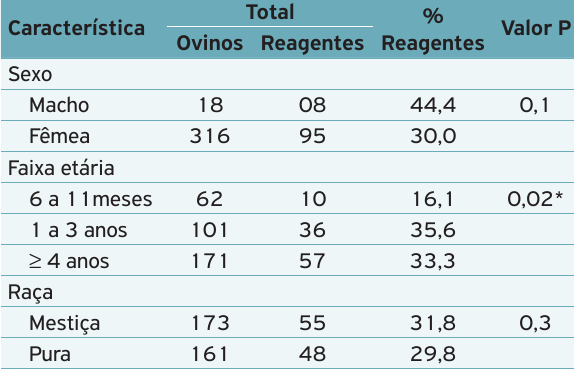
Tabela 2. Distribuição do número total de ovinos e